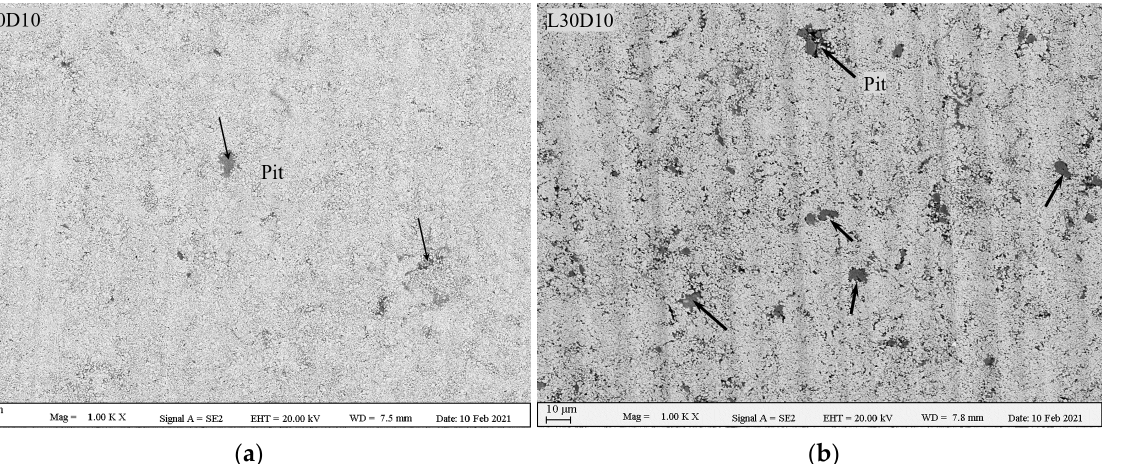
Figure 10. Specific wear rate values from ball-on-disc tests conducted for different sliding distance and load.